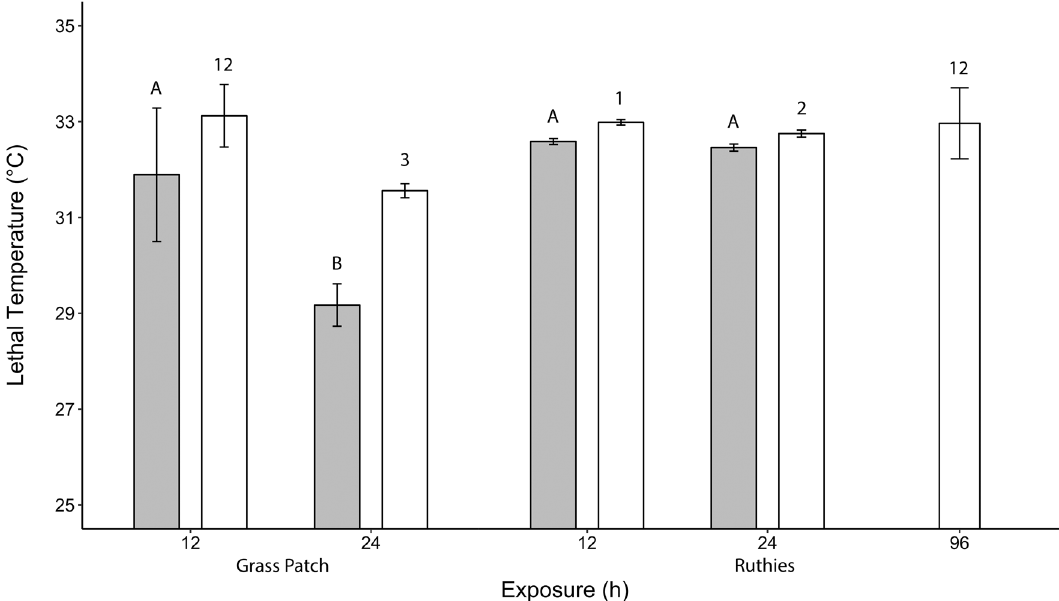
Figure 3. Comparison of lethal temperatures (LT) for 5% (gray bars) and 50% (white bars) of P. popeii glochidia (12-h and 24-h) and juveniles (96-h) from two sites in the Devils River. Error bars indicate 95% confidence intervals. LT05 values annotated with the same letters are not significantly different and LT50 values annotated with the same numbers are not significantly different based on the confidence interval ratio test ( p < 0.05).